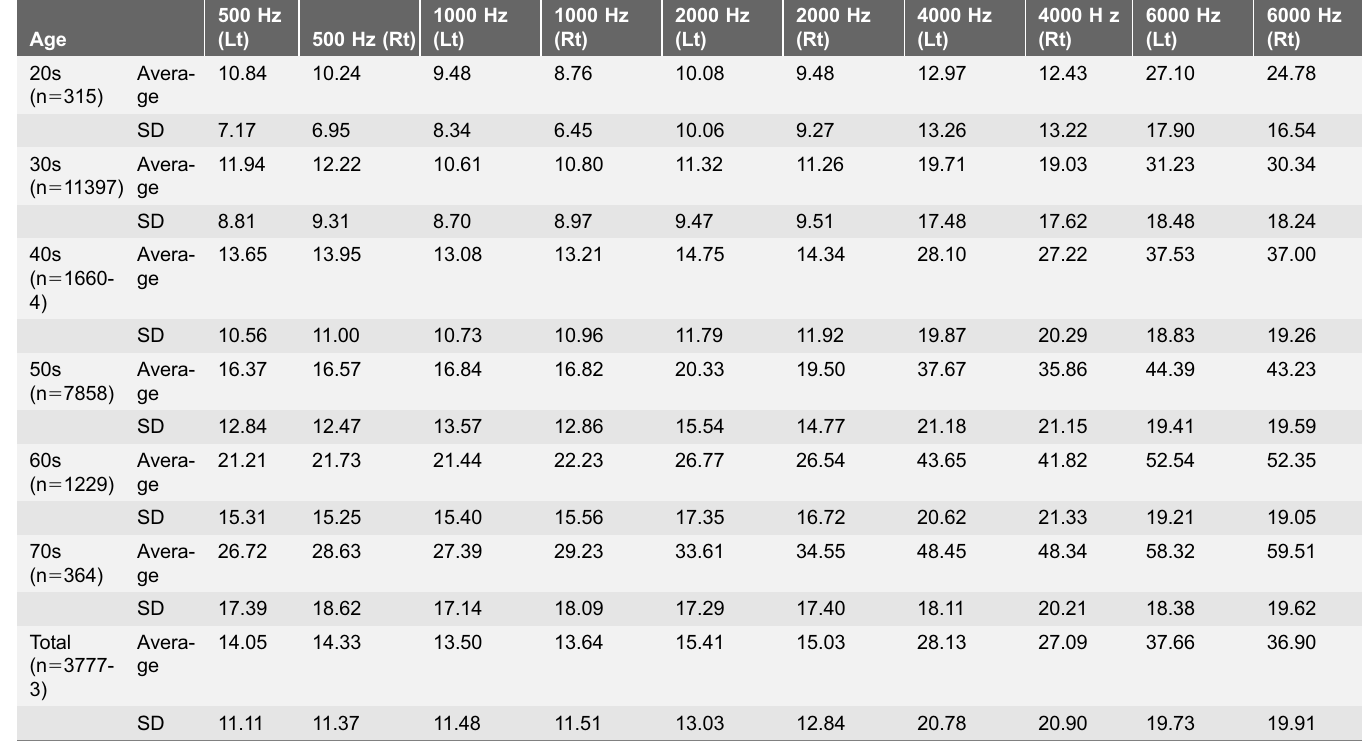
Table 1. Pure tone thresholds at each frequency stratified by